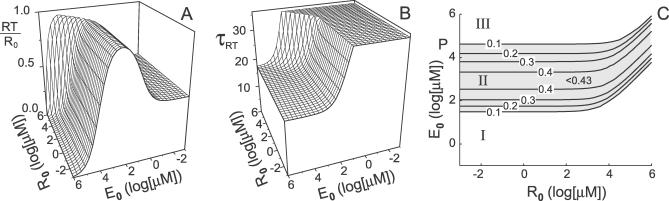
GTPase Cycling in the GEF-Only SystemThe values of the GTPase activity (A), recovery time (B), and performance index (C) are shown as functions of the total concentrations of the GTPase (R
0) and GEF (E
0). The model predicts that in the physiologically relevant range of the GTPase concentrations (R
0 ≤ 10 mM) all three characteristics do not depend on R
0. Roman numerals on the contour plot of the performance index P denote three regions with distinct GTPase cycling regimes: (I) effectively control-free, (II) processive (P > 0.1, highlighted in light grey), and (III) futile cycling within the complex with the GEF. Numbers on the contour lines indicate the levels of P.